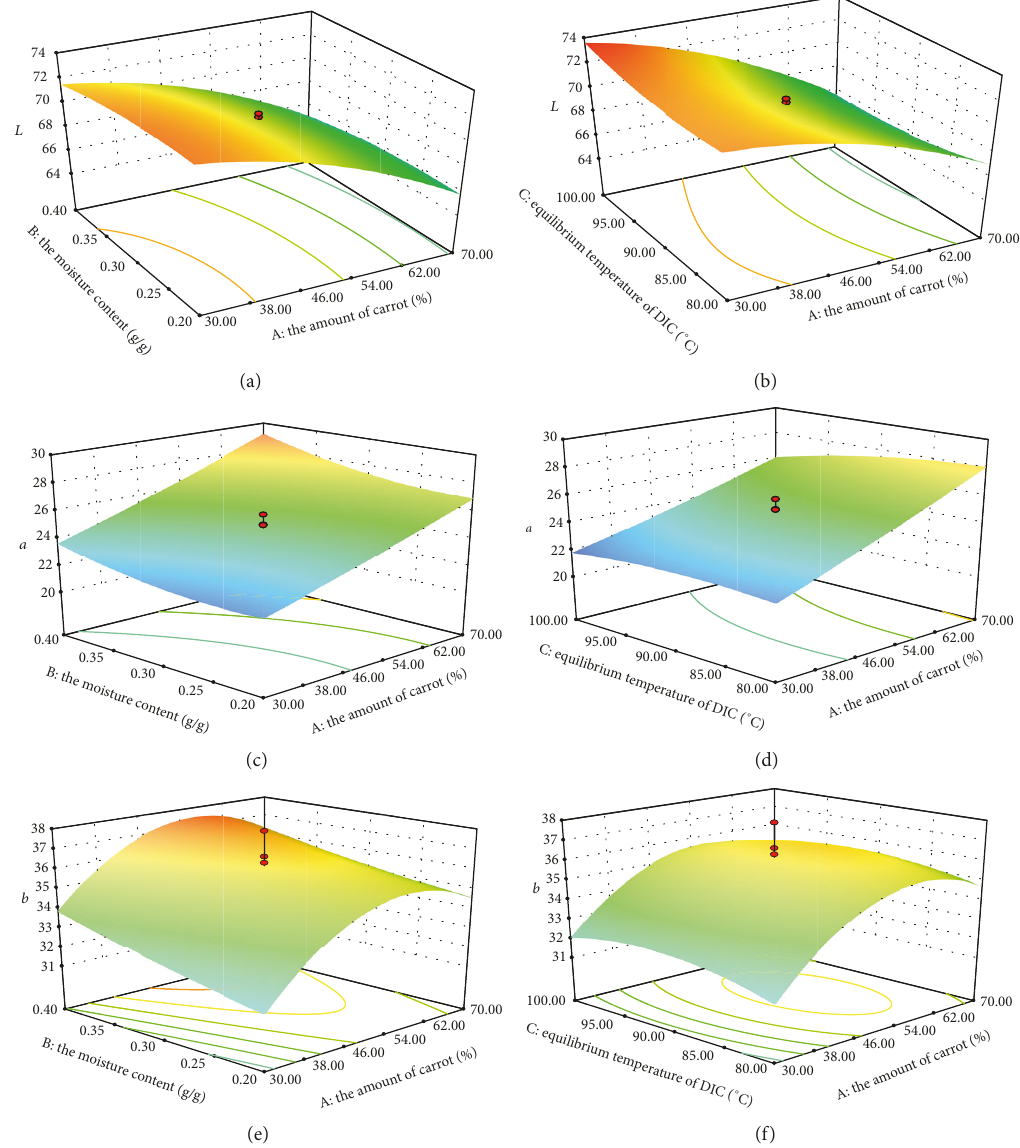
Figure 3: Response surfaces for the effect of the amount of carrot, the moisture content of the partially dried product before DIC treatment, andequilibriumtemperatureofDIConthecolorvaluesof L (a-b) ,a (c-d) , and b